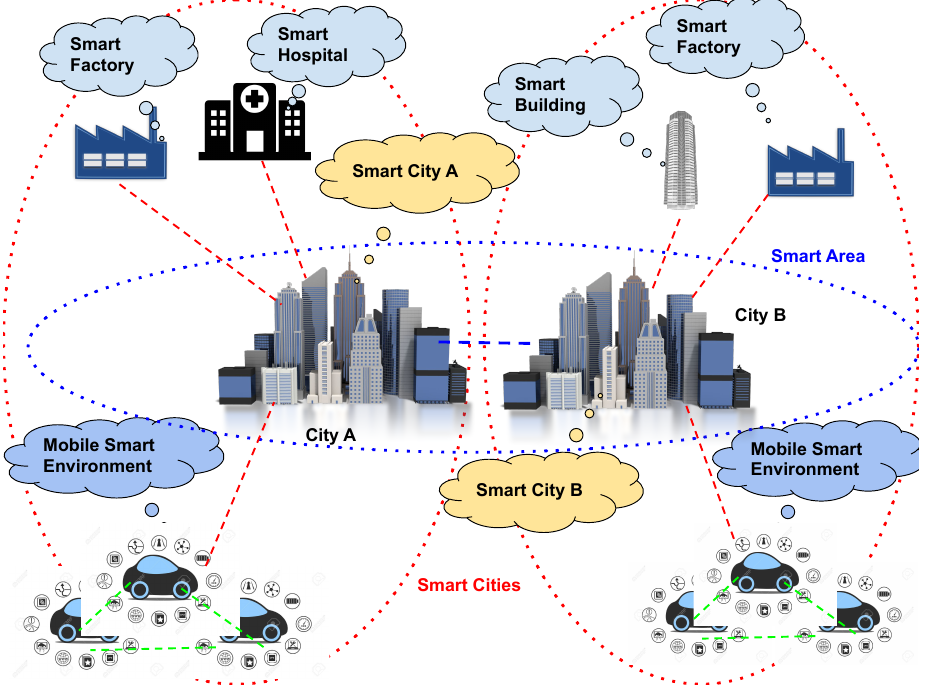
Figure 3. An example of a Smart